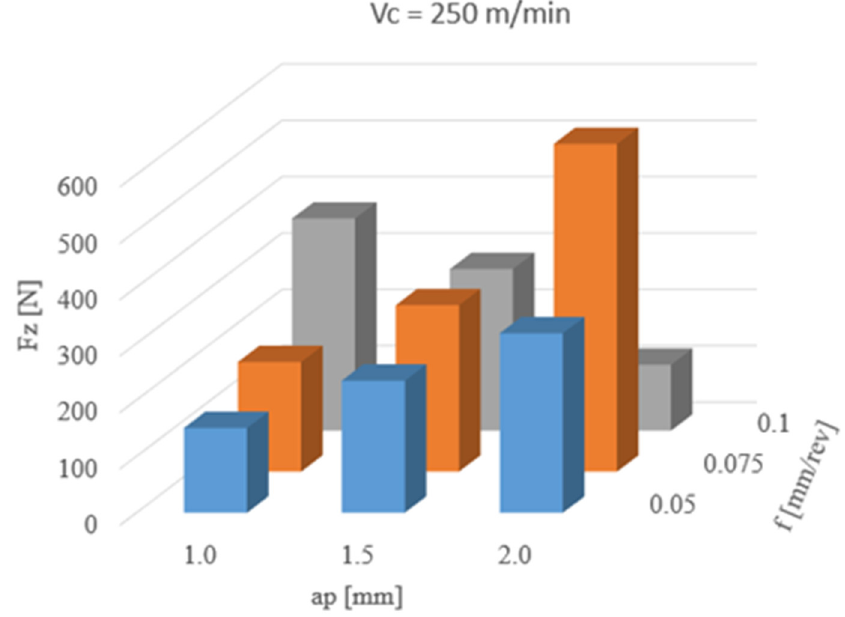
Figure 7. The results of changing cutting parameters on Fz.